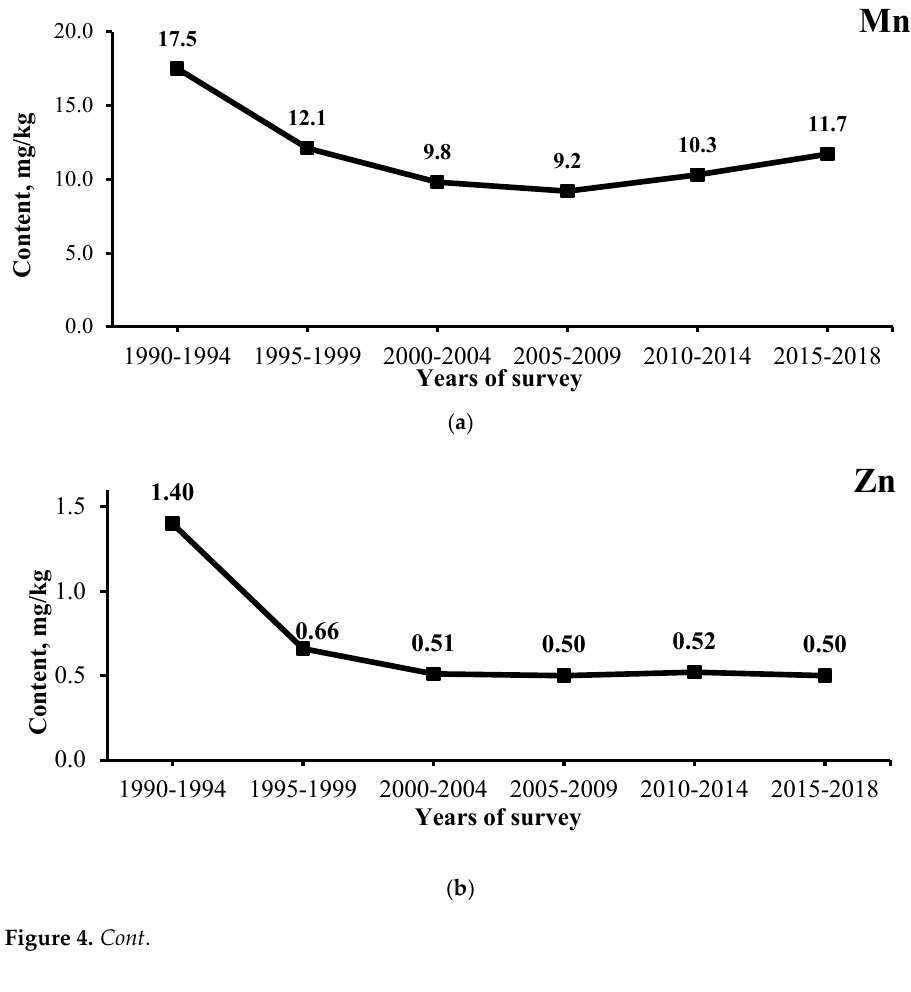
( c ) Figure 4. Dynamics of the weighted average contents of mobile forms manganese ( a ), zinc ( b ), and cobalt ( c ) in arable soils of Belgorod region, mg/kg. 3.2. The Content of Trace Elements in Plants The level of trace elements in plants is the most important ecological characteristic of agroecosystems. According to the results of the background environmental monitoring, it was found that the average contents of manganese, zinc, and cobalt in steppe grasses in The 2015–2018 survey found that 98.3% of arable soils had a low content of mobile compounds of zinc (<2.0 mg/kg); the contents of cobalt (<0.15 mg/kg) and manganese (<10 mg/kg) were 99.3% and 38.6% of manganese, respectively. The introduction of microfertilizers was effective in these soils. Arable soils with an excess of the MPC of total manganese and the APC of total zinc, as well as the MPC of the mobile compounds of the studied trace elements, were not detected in arable soils.